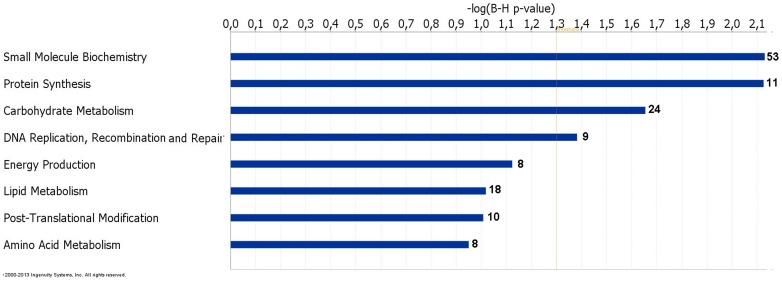
Functional grouping of DEGs in liver from boars with high and low skatole using Ingenuity Pathways Analysis (IPA) software.The most significant functional groups (p<0.05) are presented graphically. The bars represent the p-value on a logarithmic scale for each functional group.